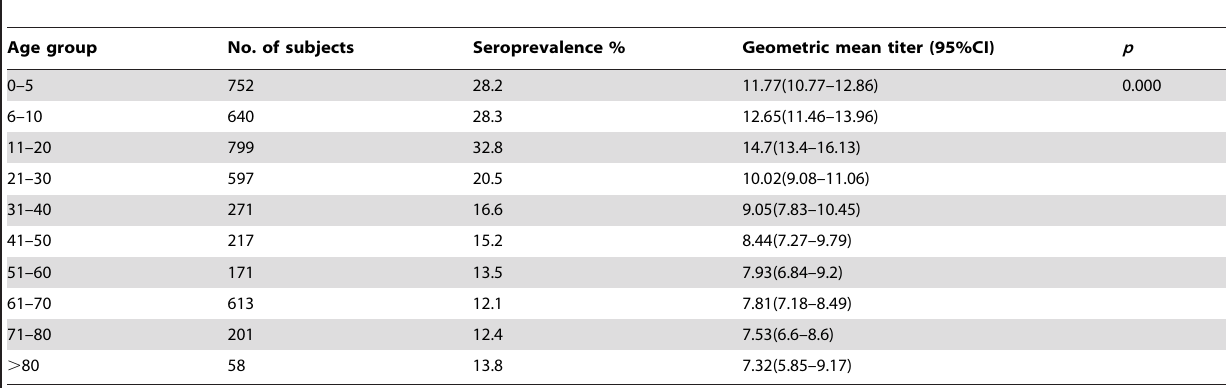
Table 2. Sample size, seroprevalences and GMTs in different age